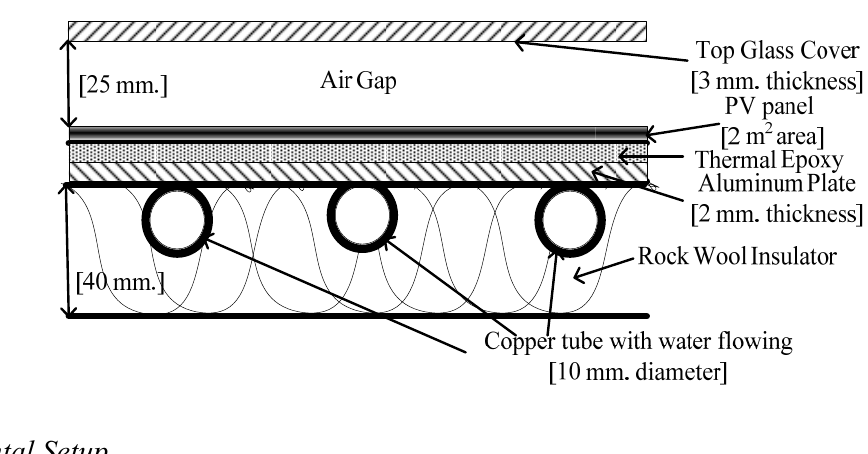
Figure 2. Cross sectional PVT collector.